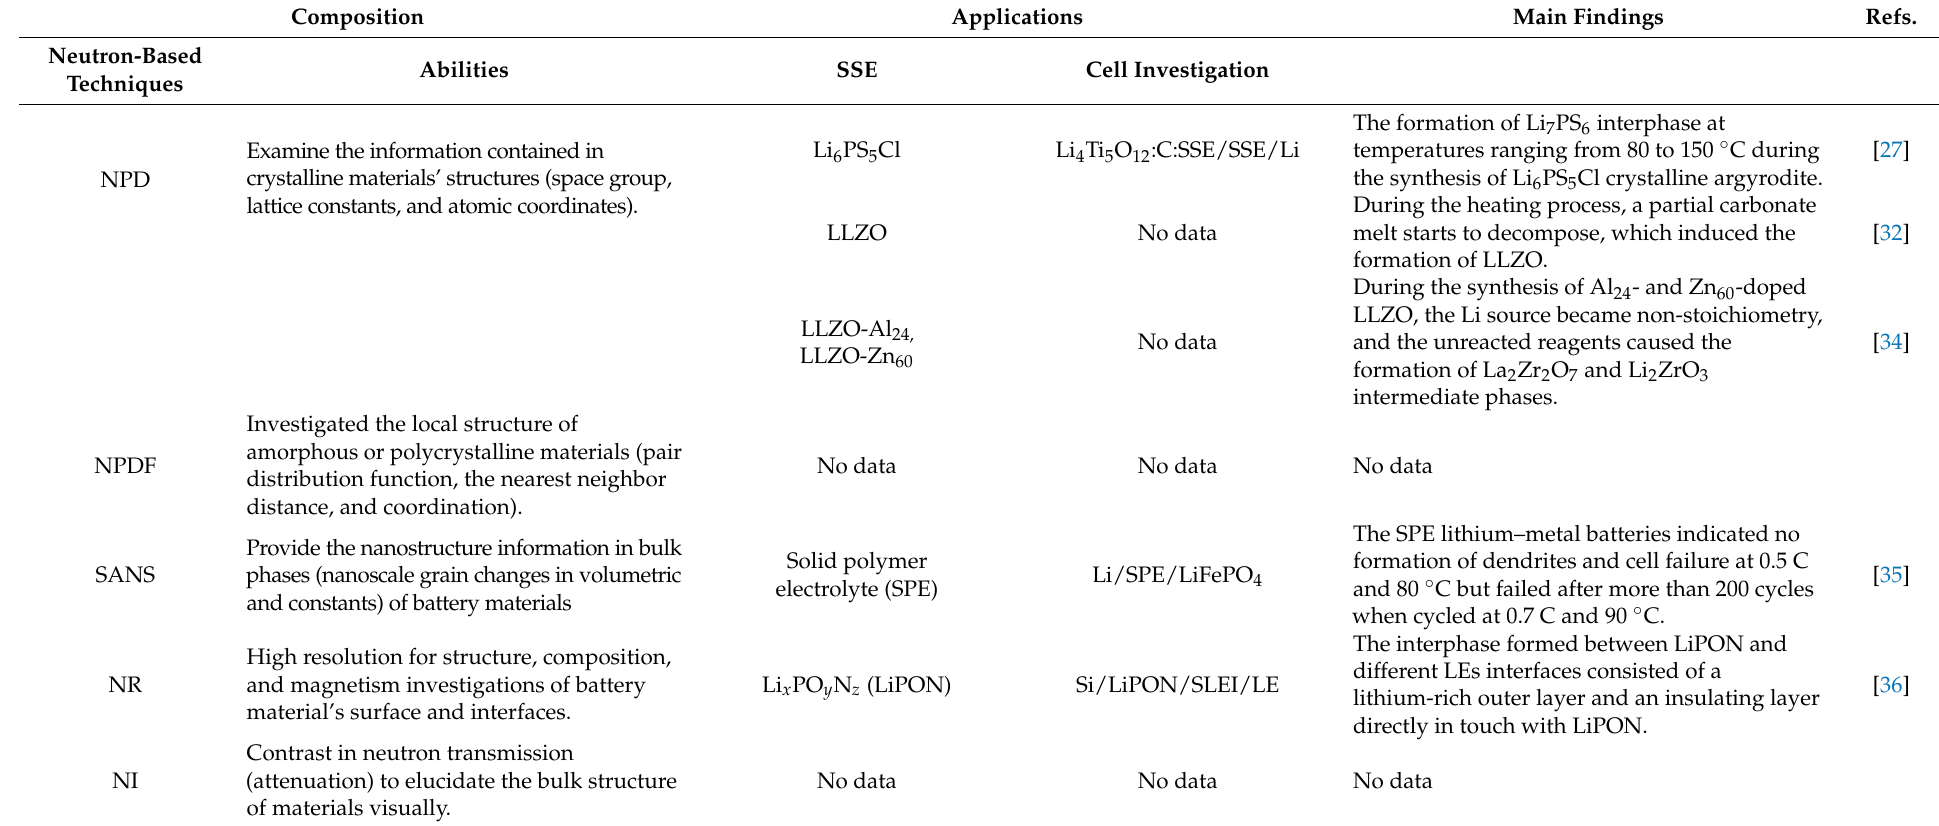
Table 1. In situ/Operando neutron-based techniques in SSLBs: capabilities, applications, and major research